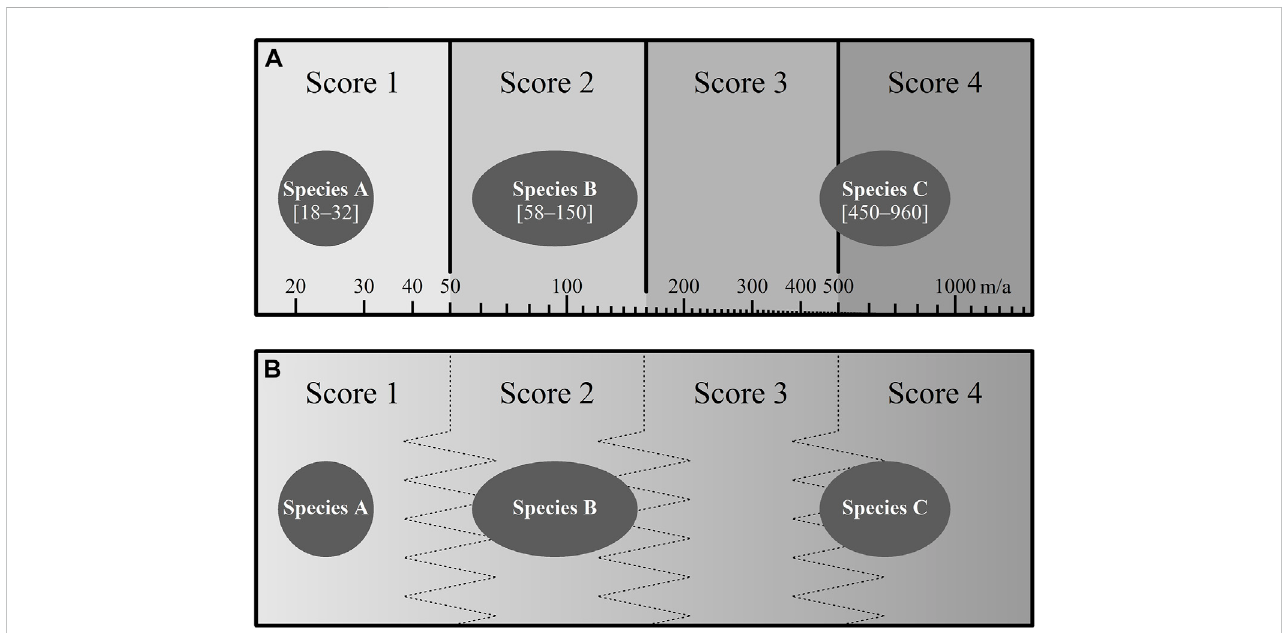
Concept fi gure illustrating three alien species in an (A) quantitative and a (B) qualitative set of criteria. Species are assigned to one of four scores based either (A) on theestimatednumerical valueoftheirexpansionspeed(in square brackets,metersper year)or (B) onexpertjudgment. Thelength oftheellipses illustratesepistemicuncertainty(e.g.naturalvariationandmeasurementerror),whereassemanticuncertaintyisillustratedbythe (A) sharpnessor (B) fuzziness of the thresholds between